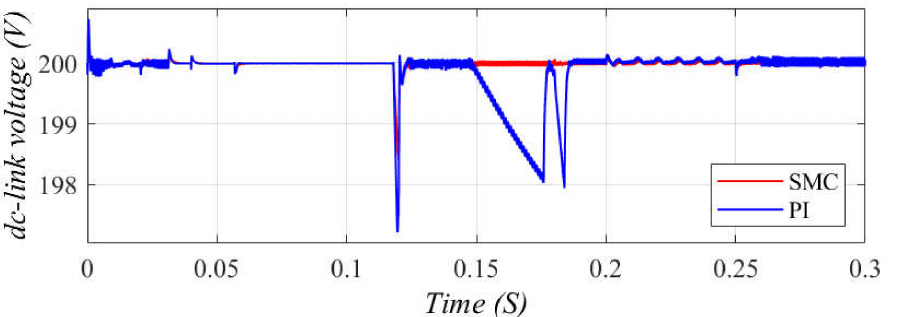
Figure 14. DC-link voltage output under load constant and radiation changes.